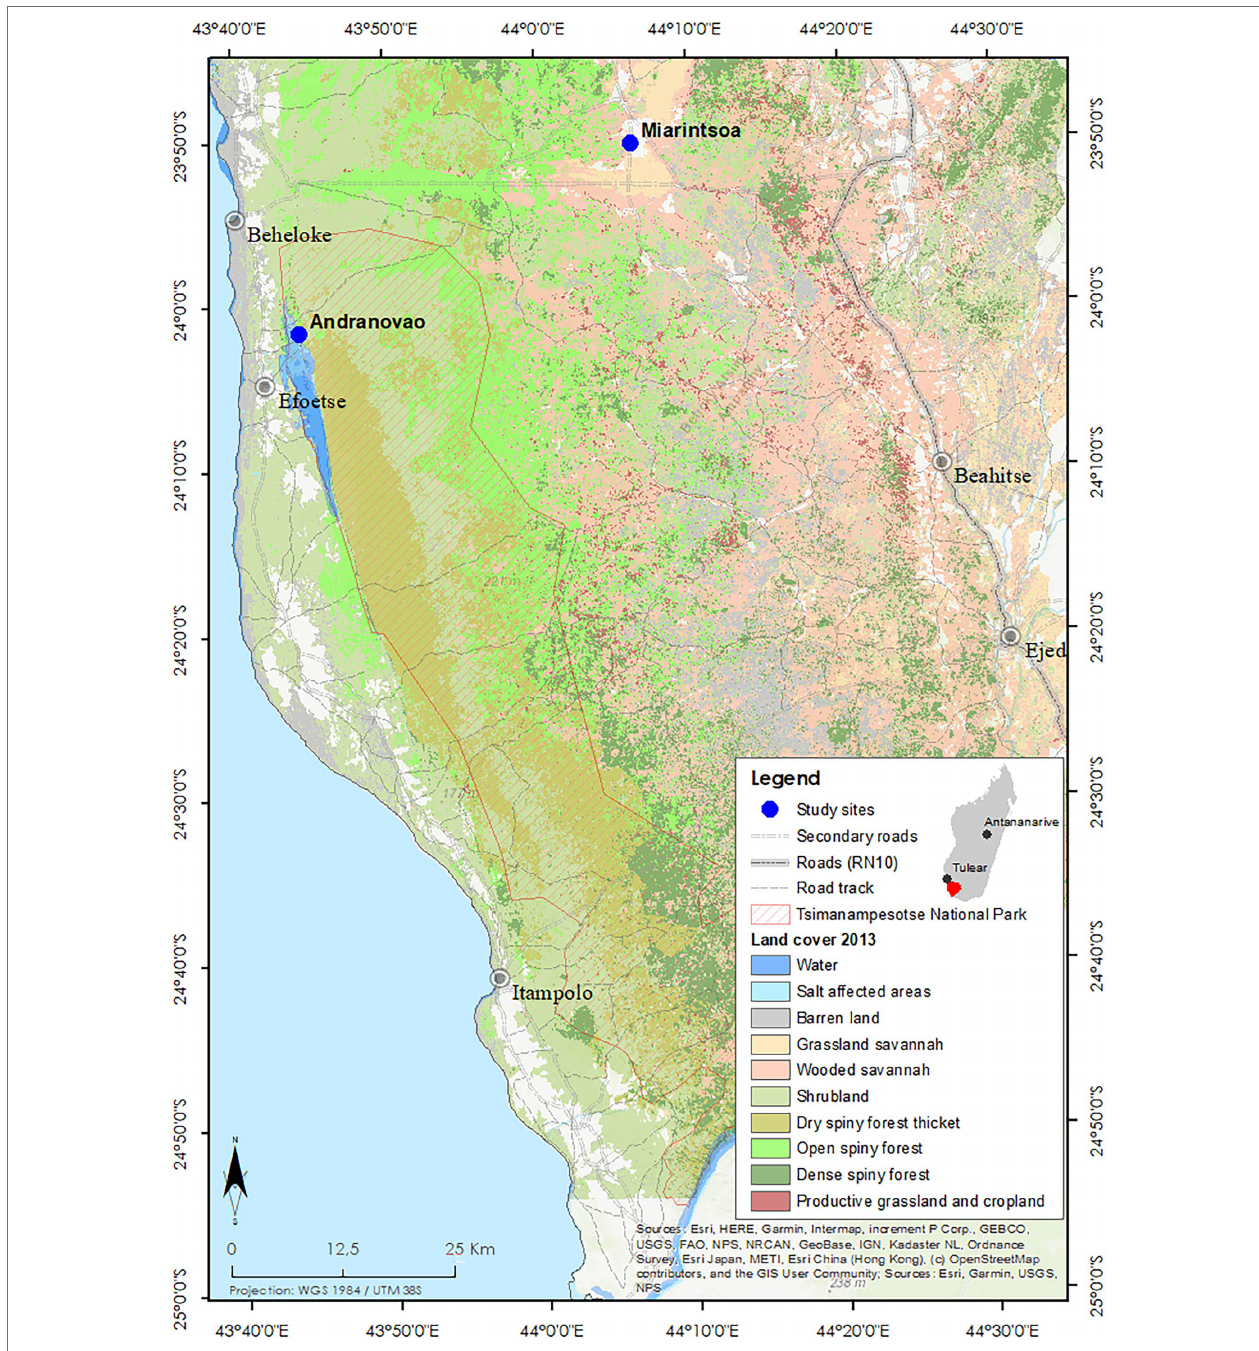
FIGURE 1 | Study area and vegetation cover in south-western Madagascar. The study sites Andranovao and Miarintsoa are marked with blue dots. The Tsimanampetsotsa National Park boundaries and the type of land cover (in 2013) are indicated (adapted from www.sulama.de by Y. R.